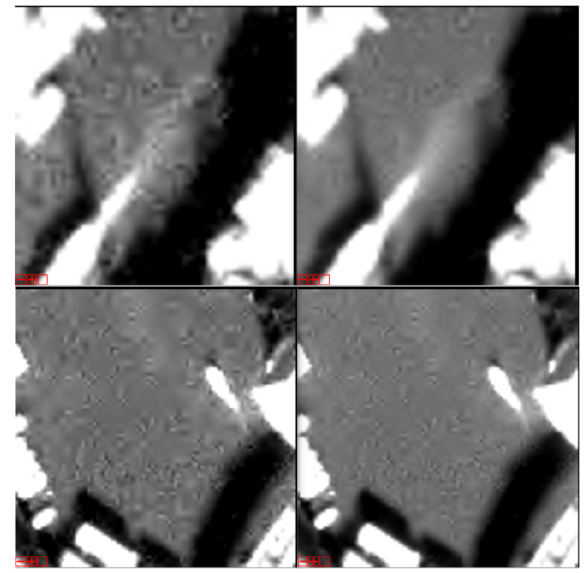
Figure 1. Pl´eiades images using the PAN detector (70cm) over Venice obtained without (Left) and with (right) noise restoration. extend the chain presented in this paper to the case of matrix detectors, in particular colour filter arrays (CFAs). Examples for Bayer CFAs (Bayer, 1975) are